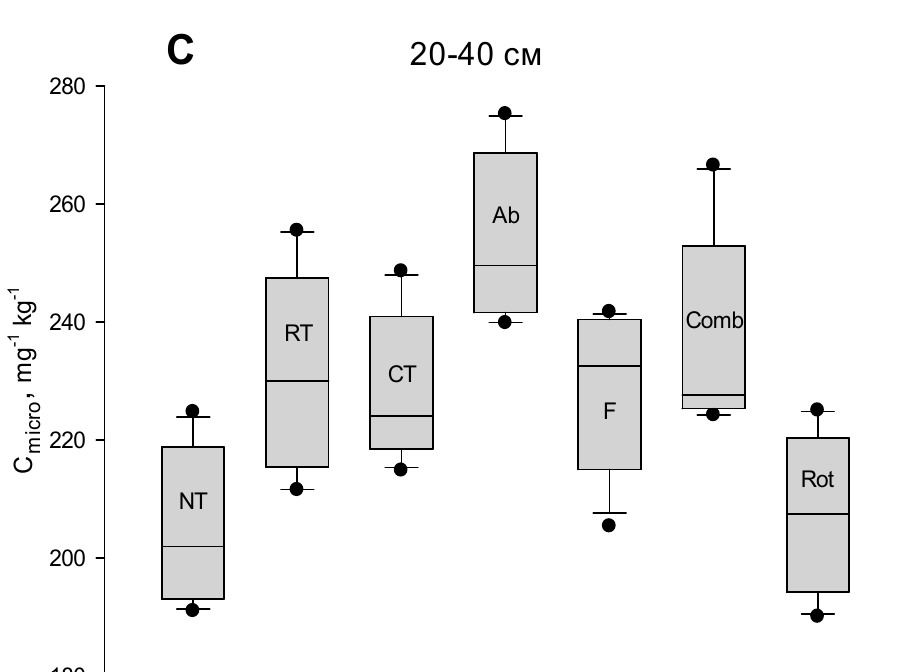
Figure 1. Sizes of seasonal dynamics (box plot 25–75%, median, n = 12, May–July–August–October) C micro in the 0 − 10- ( A ), 10 − 20- ( B ) and 20 − 40-cm ( C ) layers of Mollisol under use: conservation tillage (CT), no till (NT), reduced (ridge) tillage (RT), rotary (Rot), combined (Comb) tillage, fallow (F) and abandoned field ( A , B ).